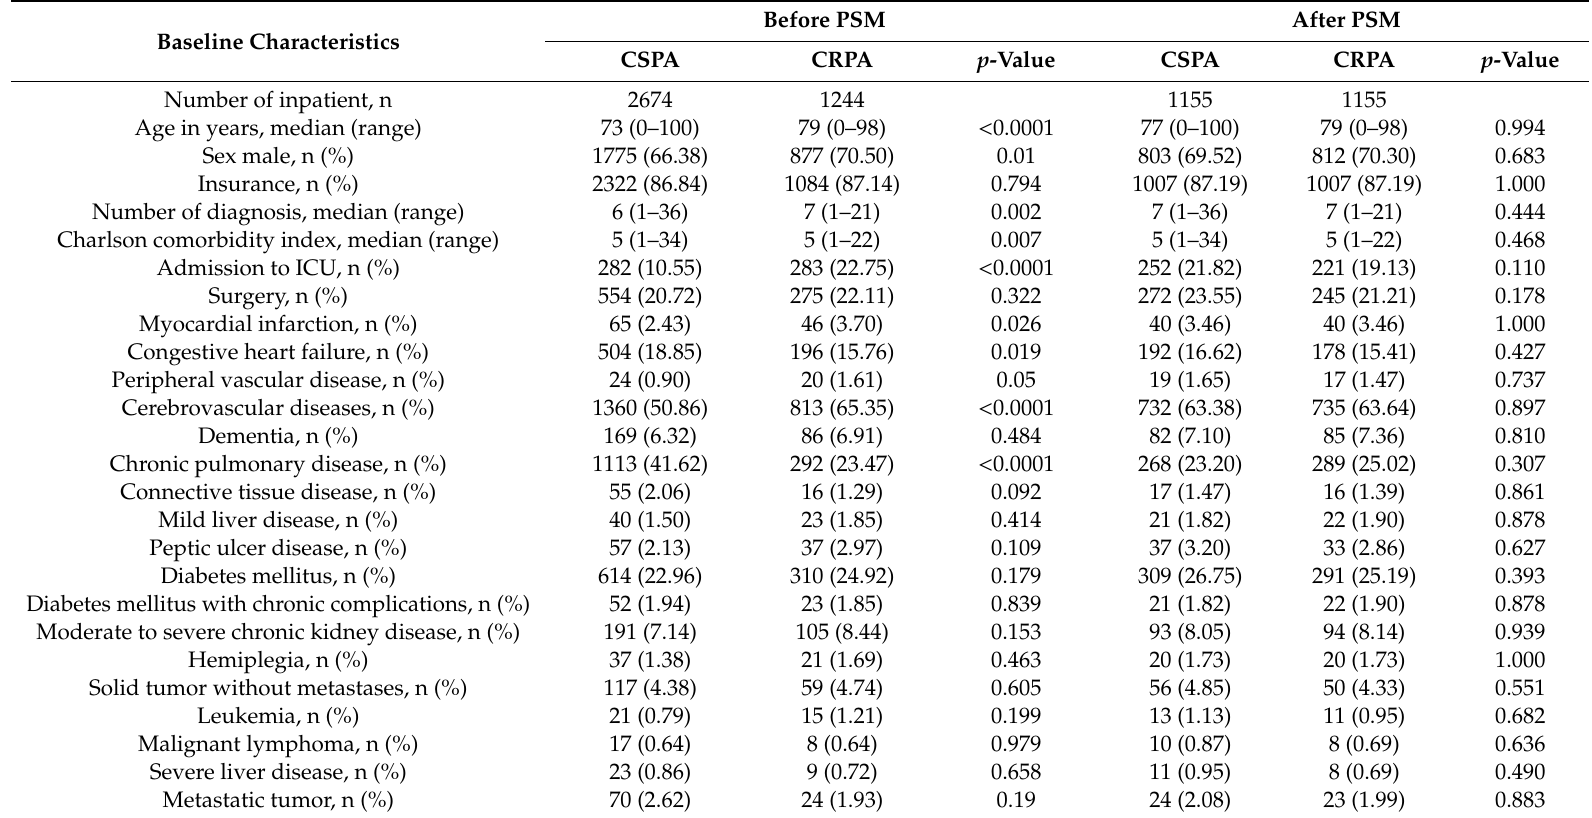
Table 2. Characteristics of the patients with CRPA and CSPA before and after